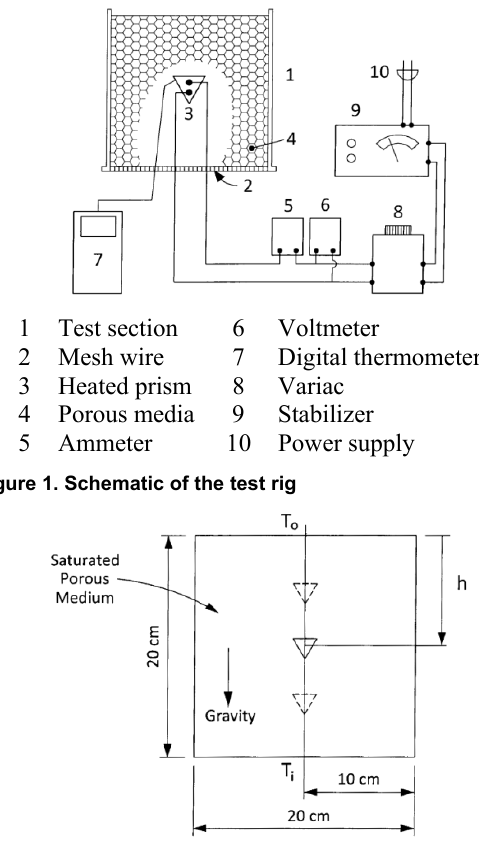
Figure 2. Details of the test